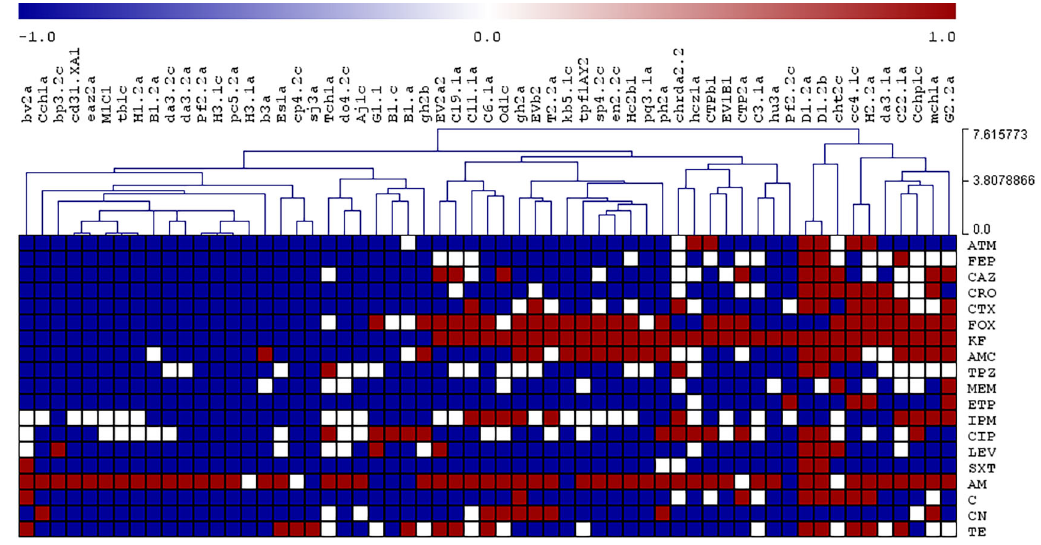
Figure 3. Profiles of antibiotic resistance and a hierarchical tree of other Enterobacterales isolates. Red: resistant, White: intermediate, Blue: sensitive. Abbreviations: TE: Tetracycline 30 μ g, AM: Ampicilin 10 μ g, KF: cephalotin 30 μ g, C: chloramphenicol 30 μ g, CIP: Ciprofloxacin 5 μ g, CTX: Cefatoxime 30 μ g, LEV: Levofloxacin 5 μ g,FOX:Cefoxitin30 μ g,STX:Trimethoprim/sulphamethoxazole25 μ g,AMC:Amoxicyllin/ClavulanicAcid30 μ g,CN: Gentamicin 10 μ g, CRO: Ceftriaxione 30 μ g, FEP: Cefepime 30 μ g, ATM: Aztreonam 30 μ g, IPM: Imipenem 10 μ g, TPZ: Piperacillin/Tazobactam 110 μ g, ETP: Ertapenem 10 μ g, MEM: Meropenem 10 μ g, CAZ: Ceftazidime 30 μ g.